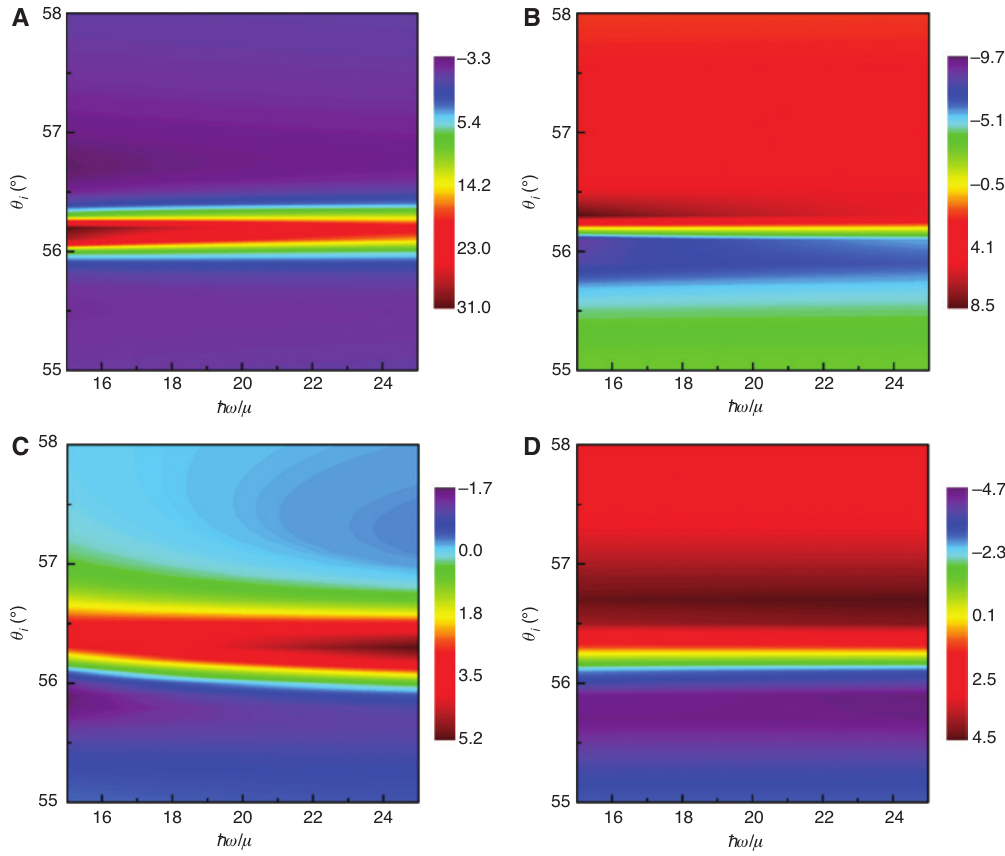
Figure 5: Influences of the incident angle and ħ ω / μ on the photonic spin Hall shifts. (A), (C) In-plane and (B), (D) transverse spin Hall shifts as a function of the incident angle and ħ ω / μ . The tilts for (A), (B) and (C), (D) are = − 2.5 and 2.5, α t